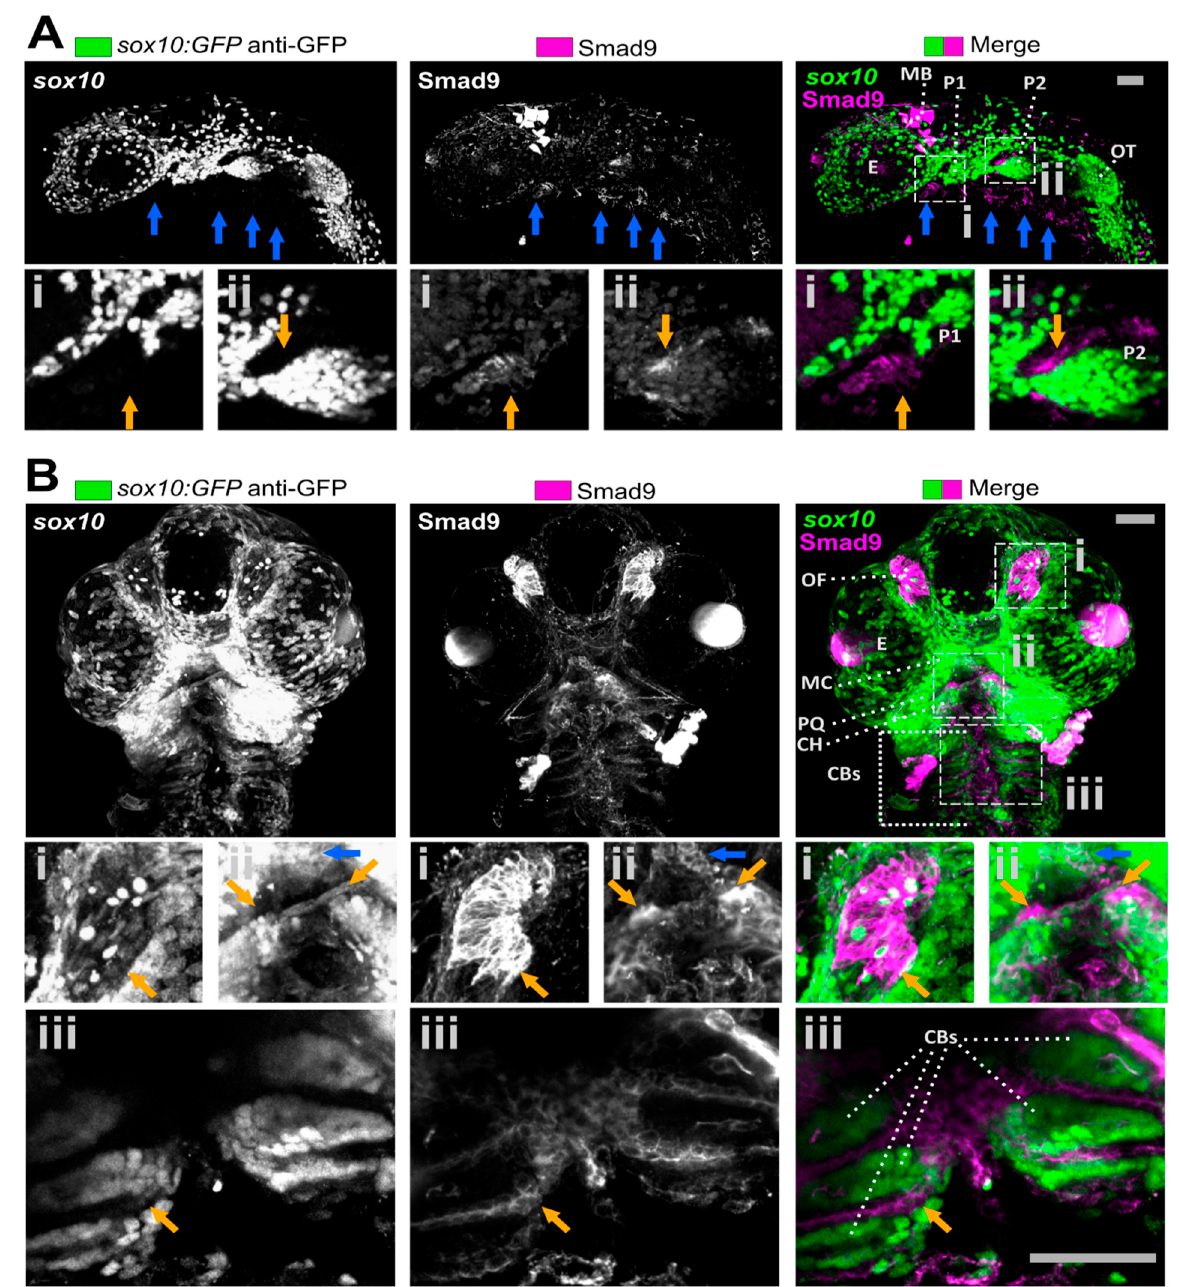
Figure 1. Smad9 is expressed adjacent to sox10 positive osteochondral progenitors in early zebrafish development. ( A ) Lateral view of a 24 hpf sox10:GFP transgenic embryo showing Smad9 expression ventrally (blue arrows) and near cranial neural crest pharyngeal pouches (orange arrows in insets). Orange arrows in the insets show Smad9 expression surrounding the anterior two pharyngeal pouches which will give rise to the MC and PQ (P1), and CH (P2). Note that Smad9 is also expressed at a low level in most GFP positive cells. ( B ) Ventral view of 48 hpf sox10:GFP transgenic fish showing Smad9 expression surrounding GFP positive cells. Insets show high Smad9 expression in the olfactory bulb (i, orange arrow), at future MC (blue arrow) and ceratohyal (orange arrow) joint symphyses (ii), and surrounding the CBs (iii, orange arrow). CBs, ceratobranchial arches; CH, ceratohyal; E, eye; MC, Meckel’s cartilage; OF olfactory placode; OT, otolith; P, pharyngeal pouch; PQ, palatoquadrate MB, midbrain. Scale bar is 50 μ m in all images.